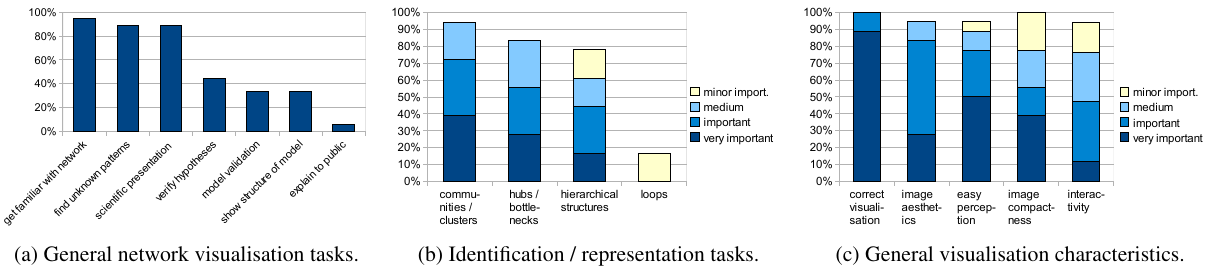
Figure 3. Tasks performed with network visualisation (a, b) and relevance of general visualisation characteristics (c) .